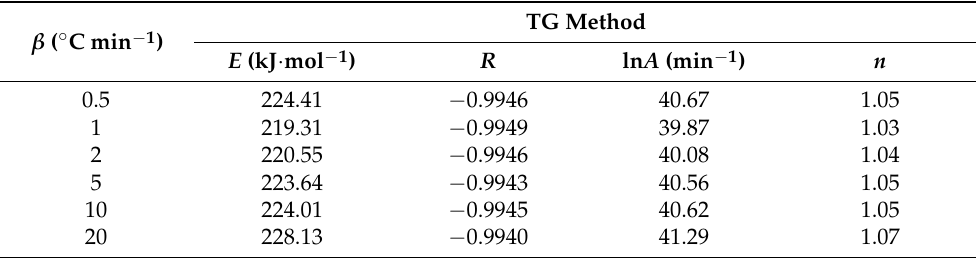
Figure 3. Ozawa plots (based on the TG method) for the activation energy of decomposition of BIIR at different α values. Table 3. Kinetic parameters of BIIR Table 3. Kinetic parameters of BIIR decomposition.